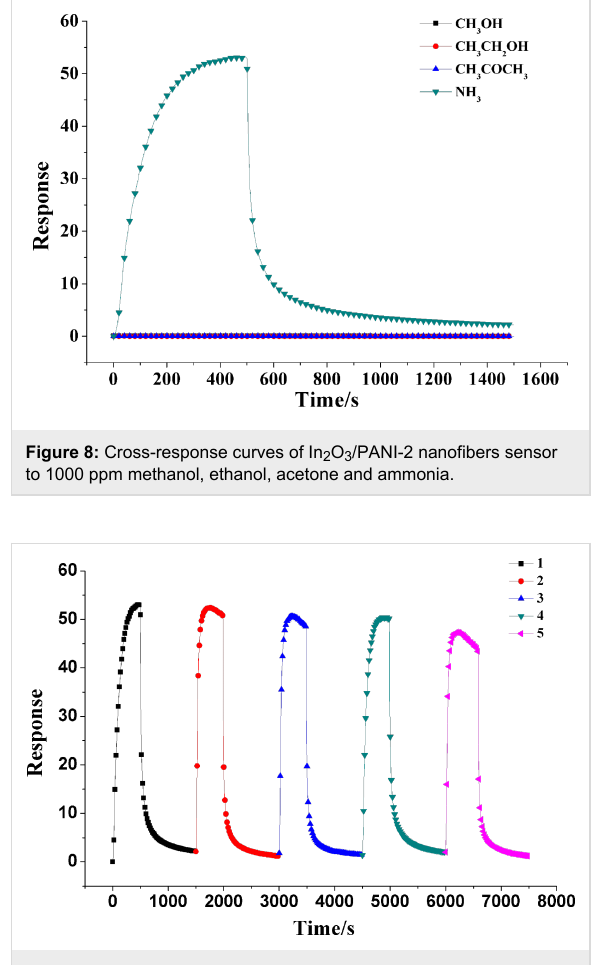
fibers, in which PANI is a p-type semiconductor and In 2 O 3